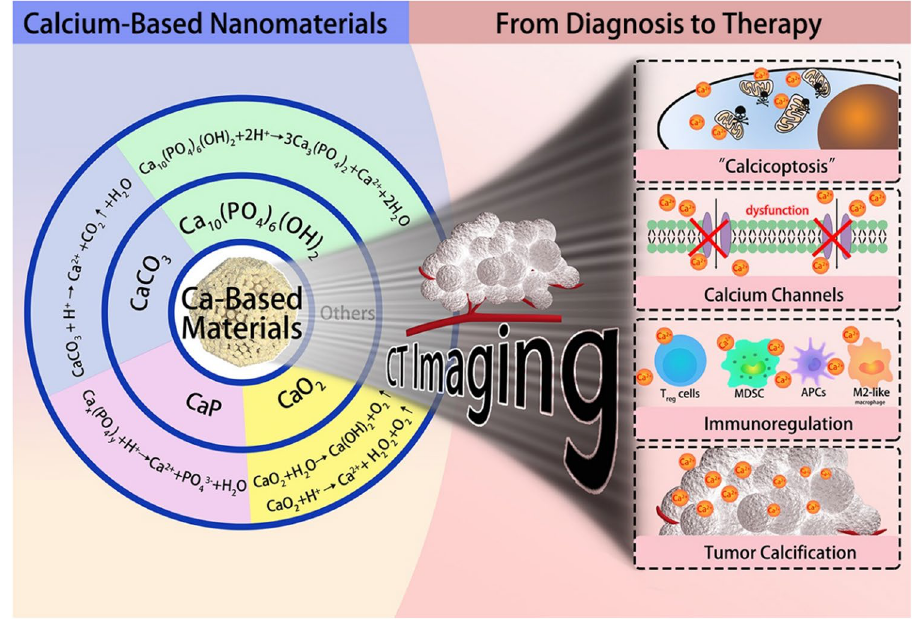
Fig. 1 Schematic illustration of calcium-based materials and calcification mediated CT imaging for cancer theranostics. Based on advanced diagnostic and therapeutic strategies, it is beneficial to translate calcium-based biochemical studies into the development of calcium-dependent potential clinical therapeutic approaches and inspire new ideas for the design and development of various calcium-based materials in the